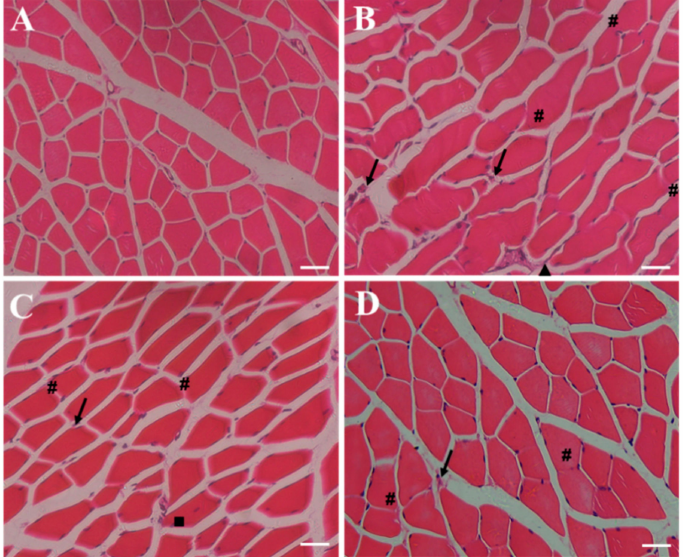
Figure 5. RSV-SLNs relieves skeletal muscle injury induced by excessive endurance exercise. Cross-sections of the histological photomicrography of GAS muscles with HE staining from the four groups of mice. ( A ): sedentary control (SC); ( B ): exhaustive exercise group (EE); ( C ): exhaustive exercise combined with resveratrol supplementation (EE + RSV); ( D ): exhaustive exercise combined with RSV-SLNs supplementation (EE + RSV-SLNs). The black arrow denotes inflammatory cell infiltrate; triangle refers to myonecrosis; square corresponds to centrally nucleated fibers; and pound sign indicates edema. The scale bars represent 200 µ m in skeletal